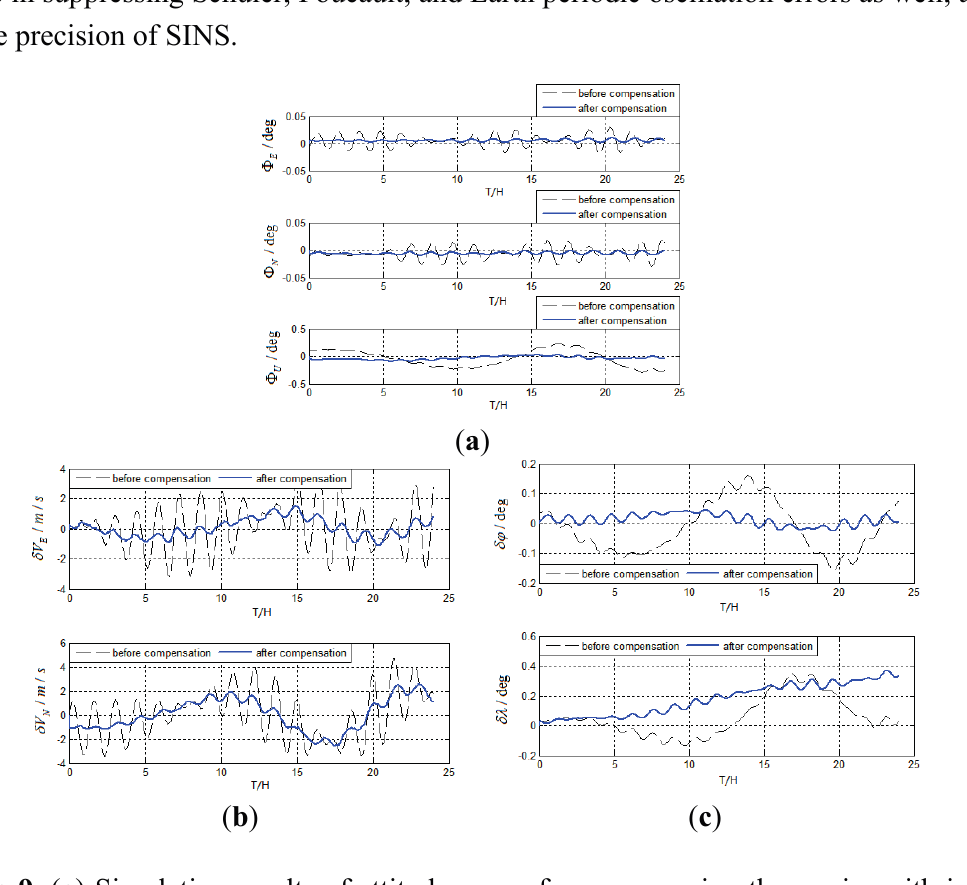
Figure 9. ( a ) Simulation results of attitude errors for maneuvering the carrier with inertia device errors; ( b ) Simulation results of velocity errors for maneuvering the carrier with inertia device errors; ( c ) Simulation results of position errors for maneuvering the carrier with inertia device